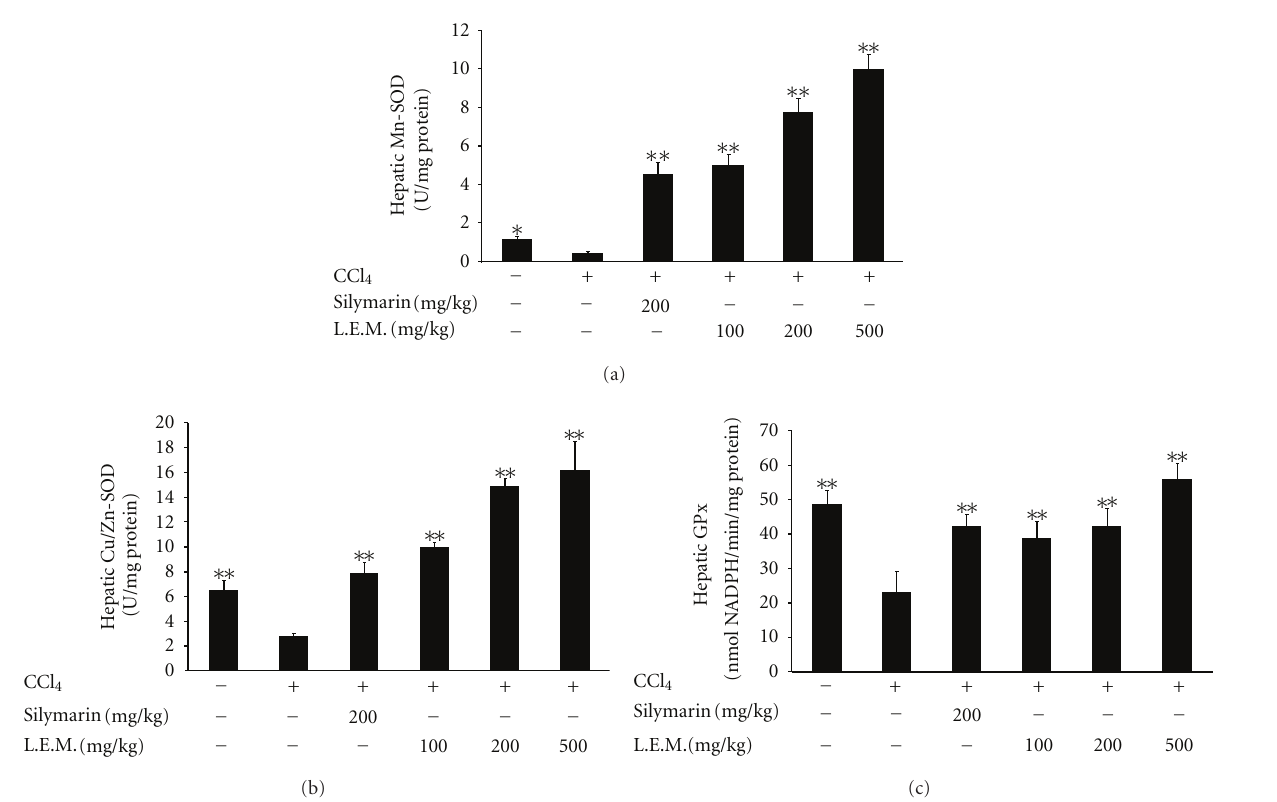
Figure 3: E ff ects of LEM on activities of hepatic Mn-SOD, Cu/Zn-SOD, and glutathione peroxidase (GPx) in CCl 4 -treated rats. (a) Changes of hepatic Mn-SOD by oral administration of LEM in CCl 4 -treated rats for 8 weeks. (b) Changes of hepatic Cu/Zn-SOD by oral administration of LEM in CCl 4 -treated rats for 8 weeks. (c) Changes of hepatic GPx by oral administration of LEM in CCl 4 -treated rats for 8 weeks. Lane 1: vehicle-treated Wistar rats; lane 2: vehicle-treated CCl 4 -induced rats; lane 3: silymarin- (200 mg/kg) treated CCl 4 -induced rats; lane 4: LEM- (100mg/kg) treated CCl 4 -induced rats; lane 5: LEM- (200mg/kg) treated CCl 4 -induced rats; lane 6: LEM- (500 mg/kg) treated CCl 4 -induced rats. Data represent mean ± SEM of eight animals. ∗ P < 0 . 05 and ∗∗ P < 0 . 01 compared with CCl 4 -induced group receiving